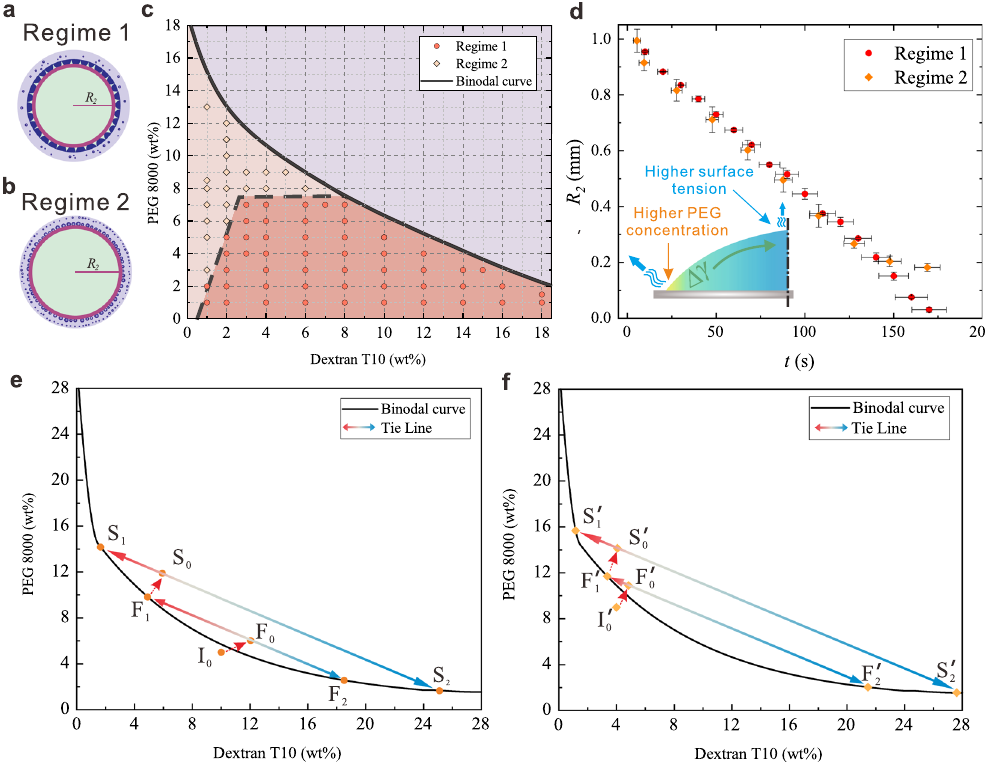
Fig. 2 Phase separation dynamics inside the evaporating droplet. a , b Schematic drawings for polymer self-organized patterns in regime 1 ( a ) and regime 2 ( b ), with the de fi nition of LLPS front that distinct single-phase region (light green color) and phase separated region (light purple for PEG-rich phase and dark purple for dextran-rich phase) inside the sessile droplet, which are demonstrated by the red solid circles with a radius of R 2 ; c Phase diagram of evaporation-triggered polymer self-organization regimes inside the sessile droplet; The phase diagram is the result of observations and analysis of at least three independent trials for each data point, with relative humidity ranging from 55 to 65%. d The radius of LLPS front R 2 as a function of evaporation time. Error bars represent SEM (standard error of the mean) from three independent experiments; Insert: Schematic drawing of nonuniform evaporation rate induced Marangoni effects. A surface tension difference Δ γ is generated due to the nonuniform evaporation fl ux along the droplet surface. e , f Kinetic pathway of LLPS in regime 1 ( e ) and regime 2 ( f ). A fi nite small area ( 4 r ¼ 0 : 05 R 0 ) near droplet edge is chosen as the calculation domain, with a time step (denoted by red arrows) of 4 t ¼ 5 s ; I 0 and I 0 are initial compositions of the single-phase droplet. F 0 and F 0 are compositions within the calculation domain 0 0 after the fi rst time step, with their exact values given in Supplementary Table 1. Once surpassing the binodal curve, the mixture spontaneously phase separates into a PEG-rich phase ( F 1 and F 0 ) and a dextran-rich phase ( F 2 and F 0 ), respectively. Similarly, S 0 and S 0 correspond to the compositions within 1 2 0 the calculation domain after the second time step (Supplementary Table 1), with the formation of a new PEG-rich phase ( S 1 and S 0 ) and a new dextran-rich 1 phase ( S 2 and S 0 ), respectively. Source data are provided as a Source Data fi 2